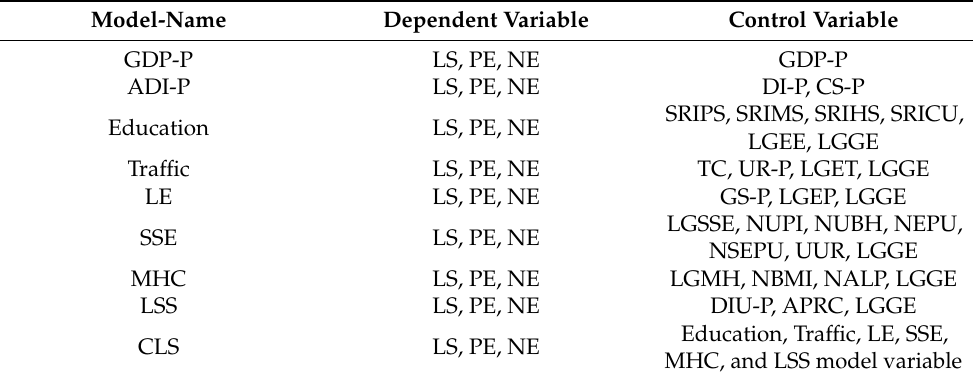
Table 3. The relationships between model names, dependent variables and control variables. Model-Name Dependent Variable Control Variable GDP-P LS, PE, NE